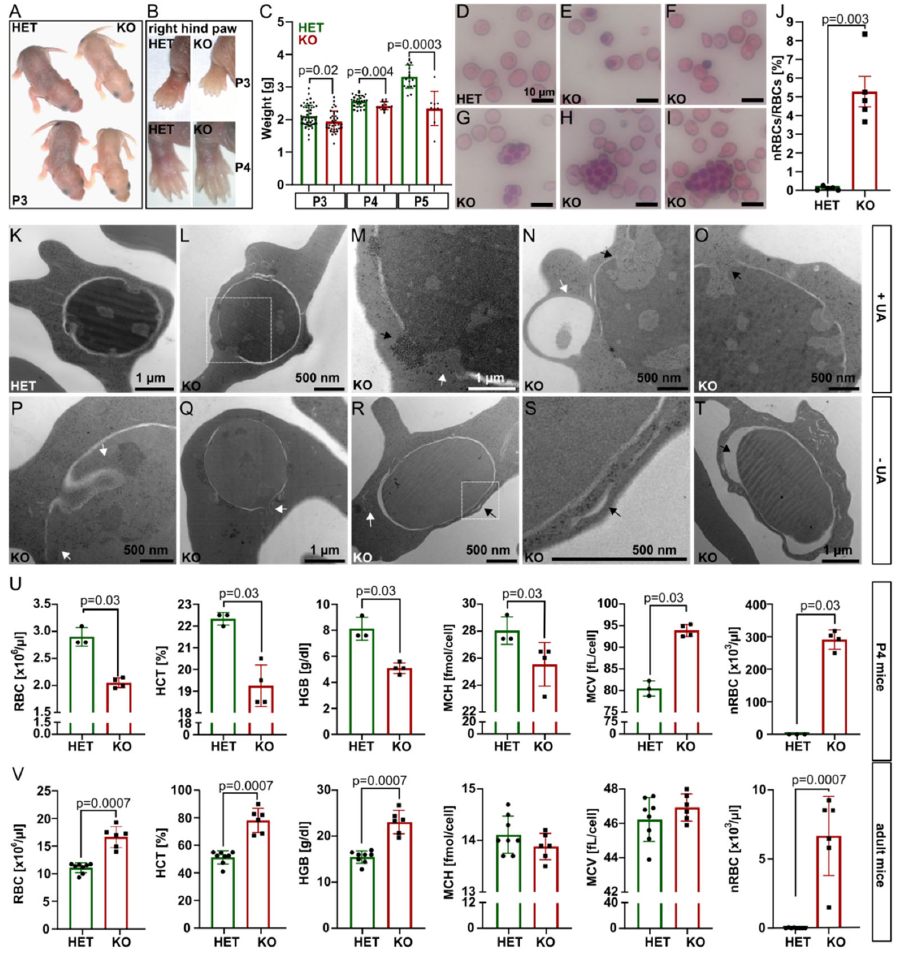
Figure 1. Tmcc2 knockout mouse apparent phenotype. ( A ) Tmcc2 − / − pup appearance, ( B ) pallor of